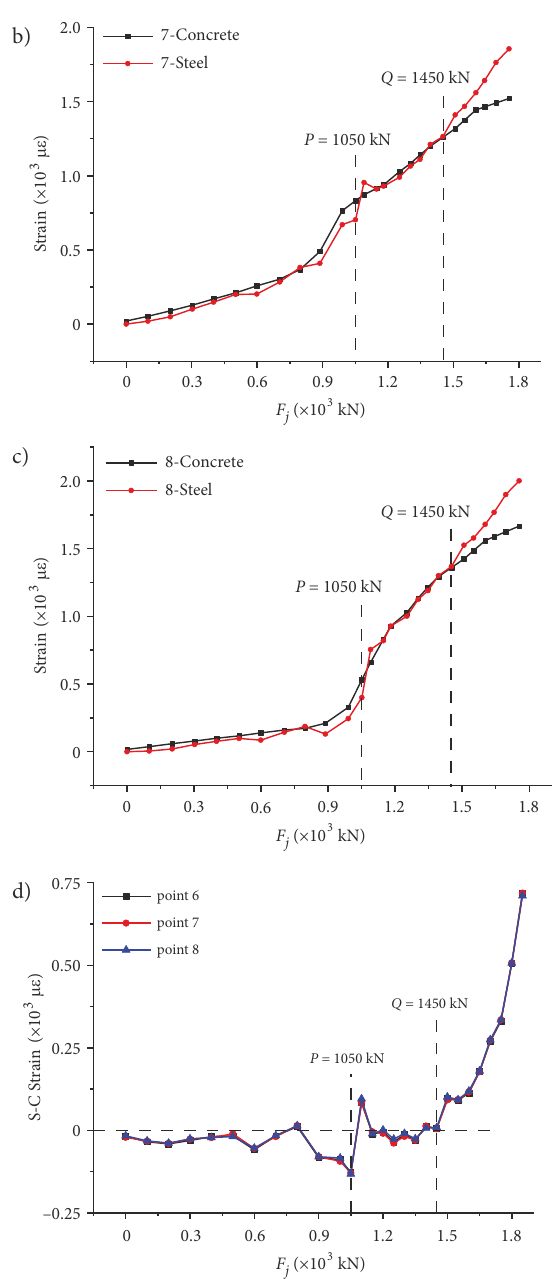
Figure 10. The bonding performance between steel bar and con- crete: (a) Strain- F curves of steel and concrete at points 7 curve; (b) Strain- F curves of steel and concrete at points 8; (c) Strain- F curves of steel and concrete at points 9; (d) S-C Strain (the dif- ference value of stain between steel and concrete)- F curves at points 7, 8 and